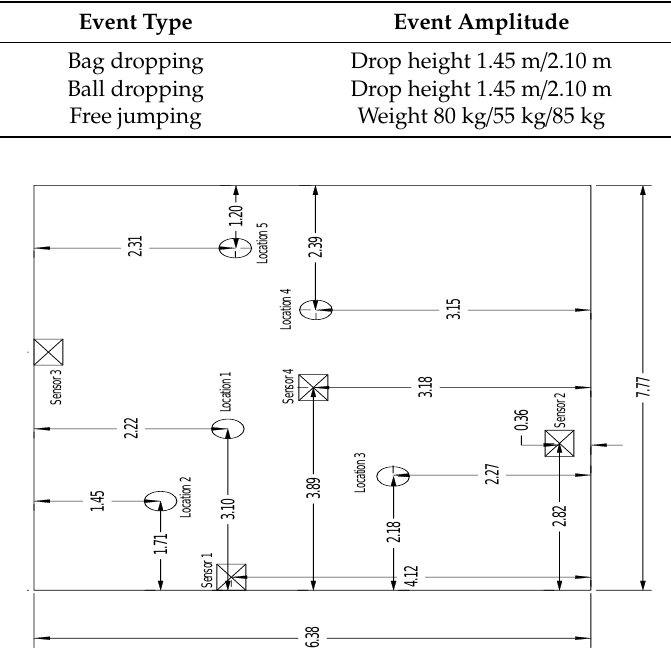
Figure 13. Sensor and impact locations in benchmark experiment (unit: m) [12].